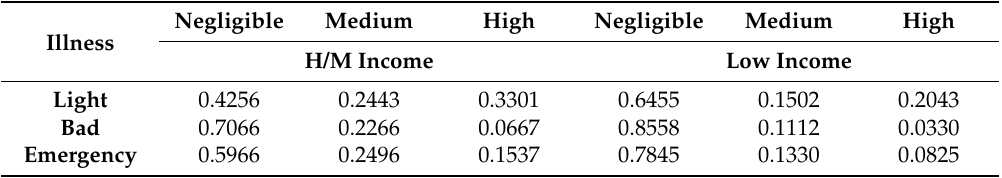
Table 12. Probabilities of envelope given by patients’ illness and income rank.